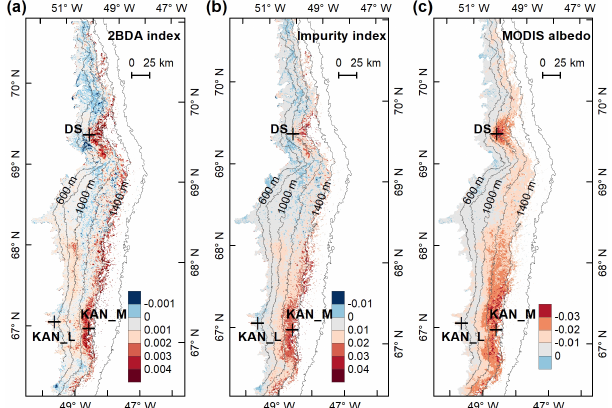
Figure 7. Interannual trends (regression coefficients with year) of the 2BDA index (a) , impurity index (b) , and MODIS albedo (c) from 2004 to